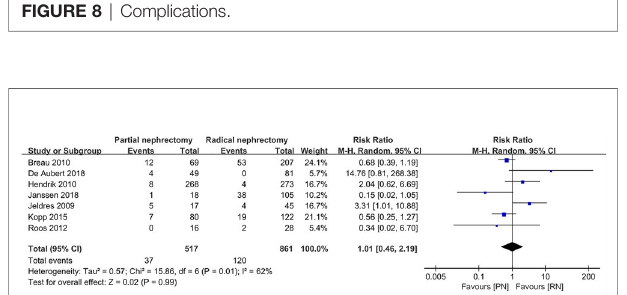
FIGURE 8 | Complications.